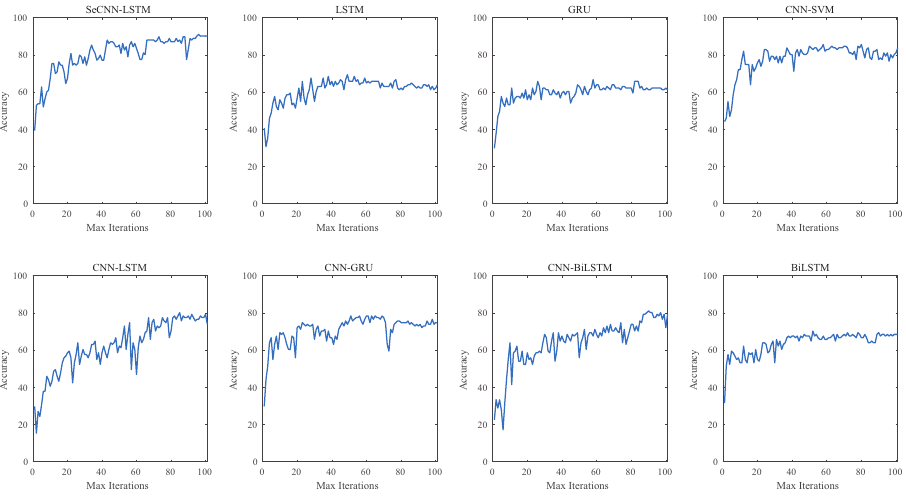
Figure 12. Test accuracy